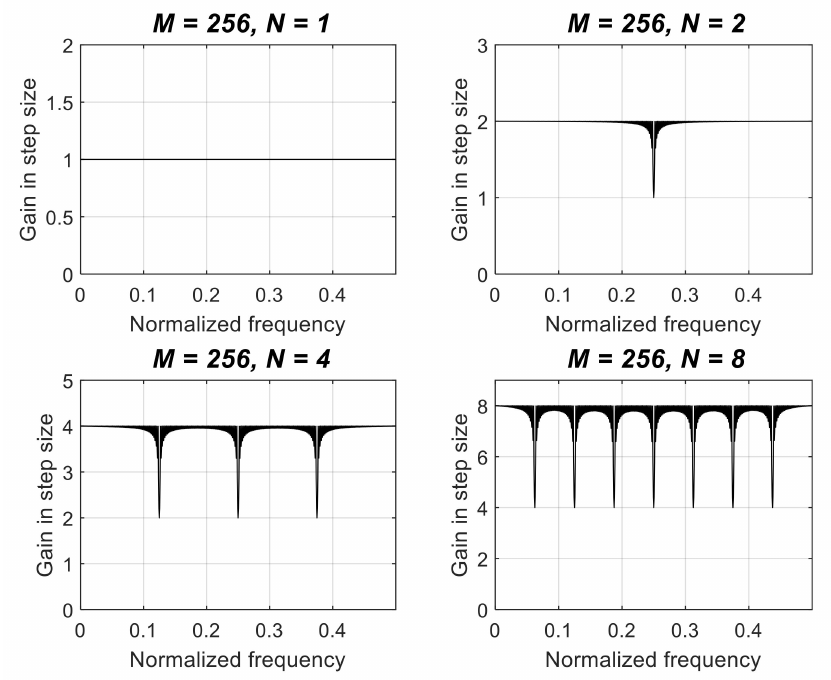
Figure 2. Gain in step-size for decimation factors, N = 1, 2, 4, and 8 for a single tone. The number of coefficients of the filter is set to M = 256.